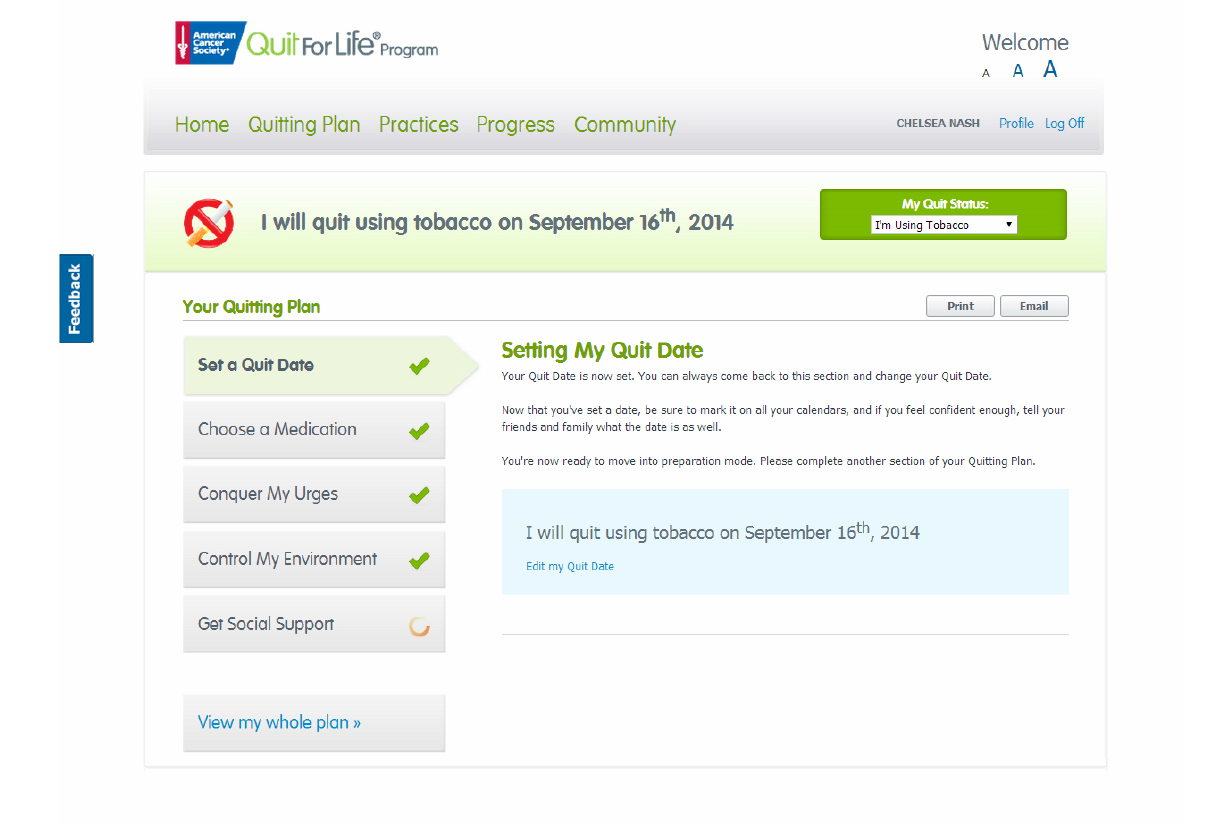
Figure 2. Screenshot of Quitting Plan webpage: setting a quit